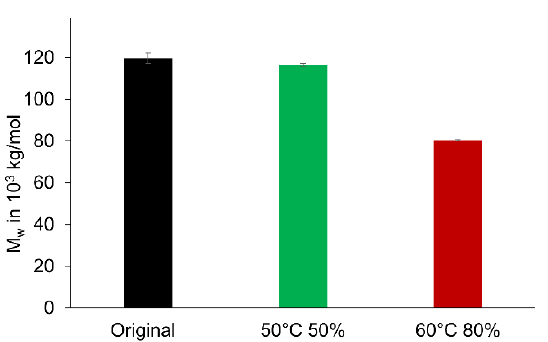
Figure 2. Molecular weight, determined with GPC, of PLA in fibers after manufacturing (original) and after artificial aging under indicated conditions.